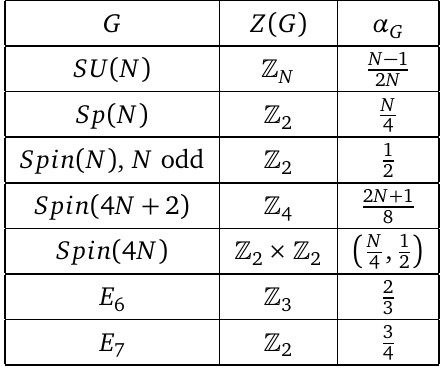
Table 1: Center 1-form symmetries for simply-connected gauge groups [ 14 ] , and co- efficients of the fractional instanton density in a non-trivial background C For Spin ( 4 N ) we have two coefficients α butions given by P ( C not have center